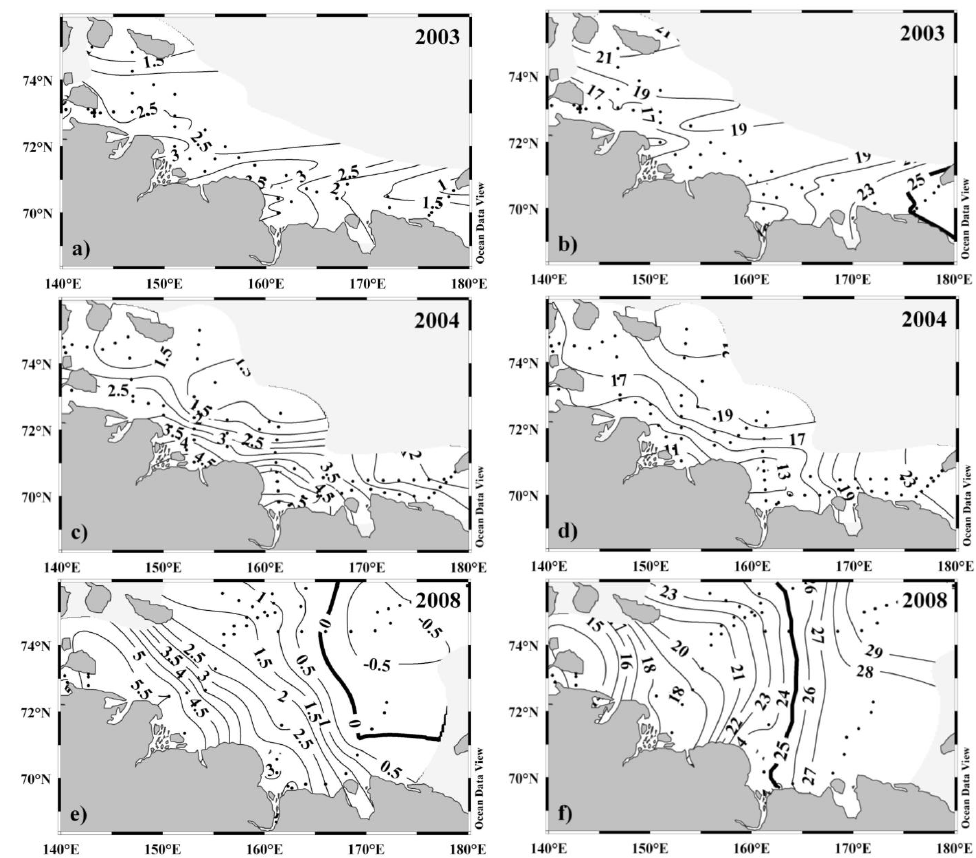
Fig. 5. Spatial distributions of sea surface temperature ( ◦ C) (a, c, e) and salinity (b, d, f) in the ESS during the 2003, 2004, and 2008